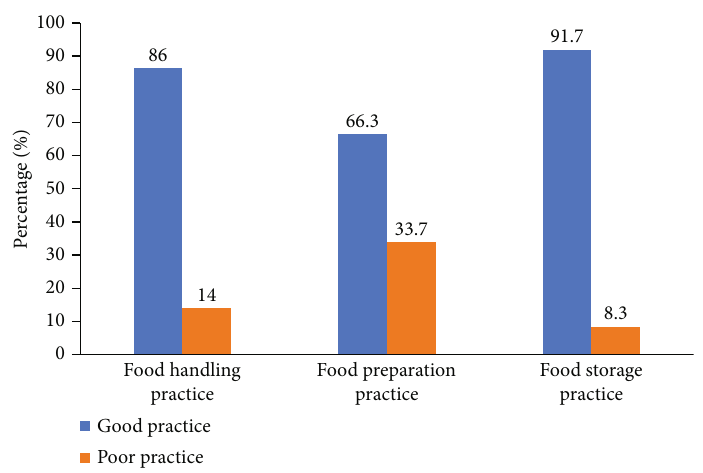
Figure 3: Food handling, preparation, and storage practices among respondents. Table 5: Association between food handling practices and respondent ’ s demographic